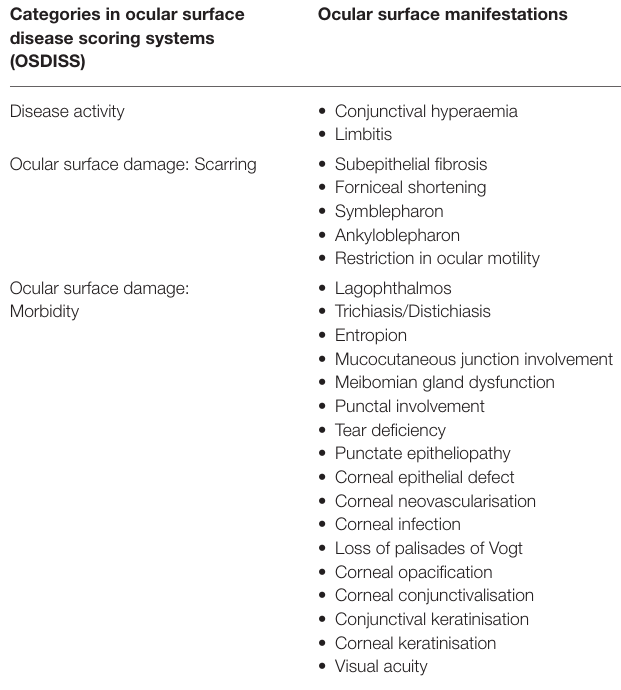
TABLE 2 | Categories of ocular surface manifestations in ocular surface disease scoring systems